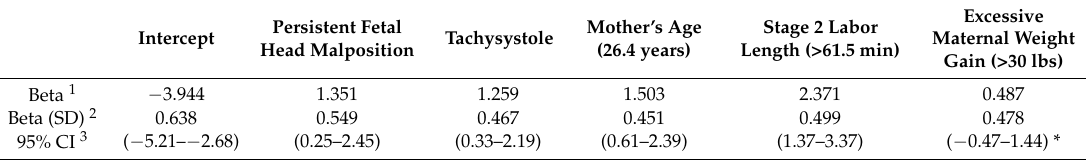
Table 3. Logistic regression summary statistics with the predicted calculated probability based on all combinations of the five variables, using combined imputed data sets ( n = 5) with MICE.